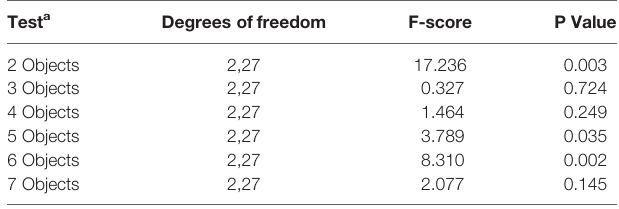
TABLE 4 | MANOVA results for memory load time spent exploring